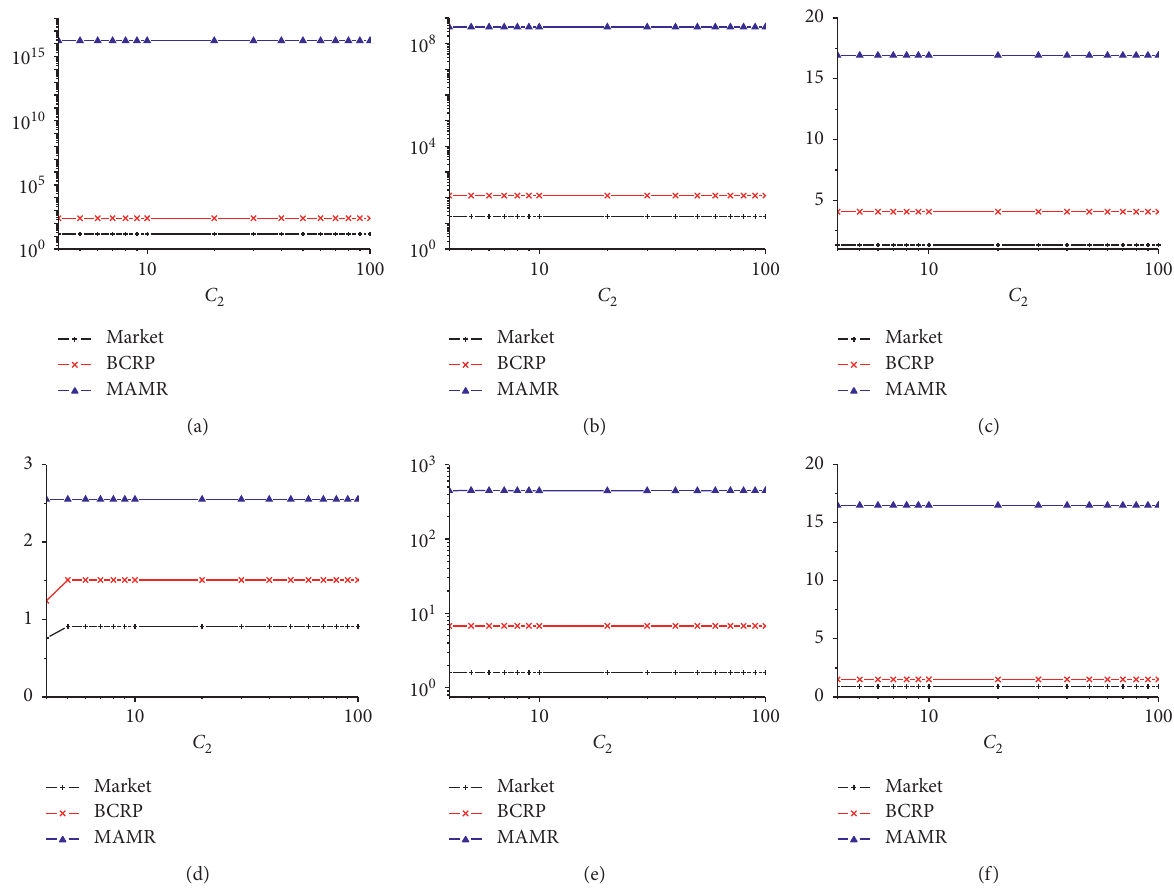
with fixed ε � 10, w � 5, and C 2